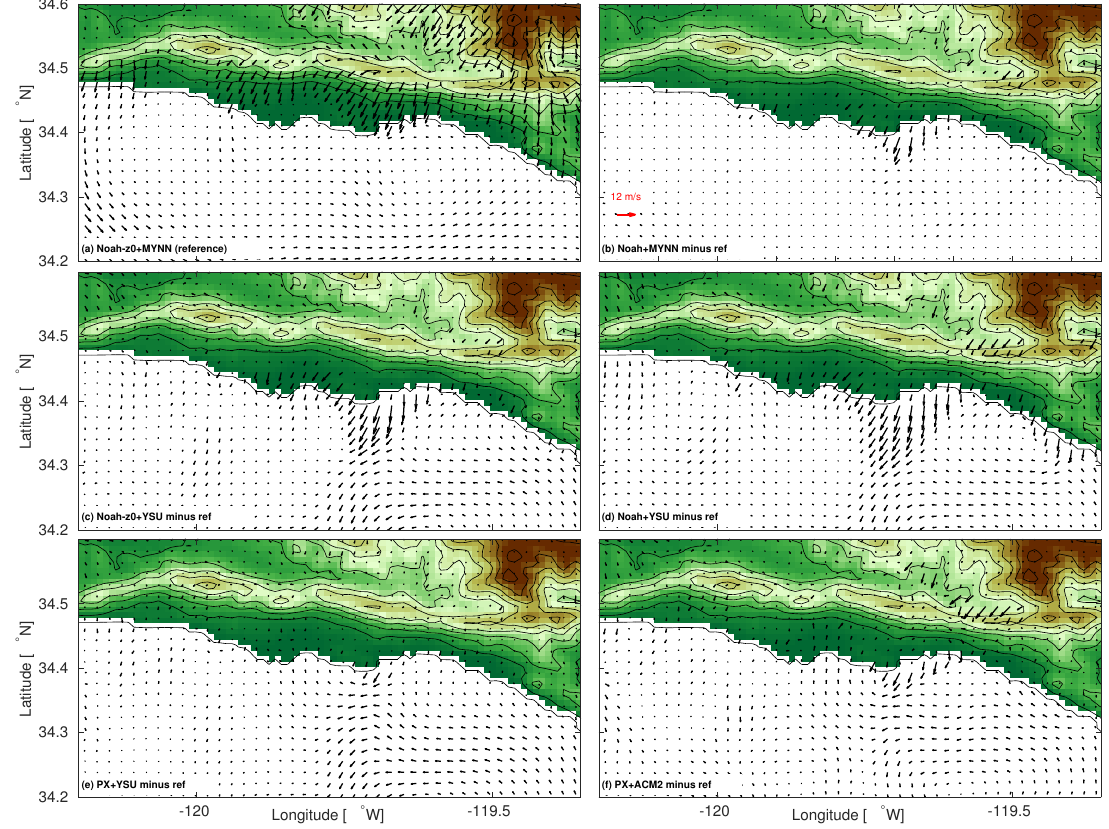
Figure 11. ( a ) Simulated 10 m winds using Noah- z 0 + MYNN configuration as a reference, and ( b – f ) differences between the indicated configuration and reference configuration after averaging between 11 March 2017 20:00 PST and 12 March 2017 02:00